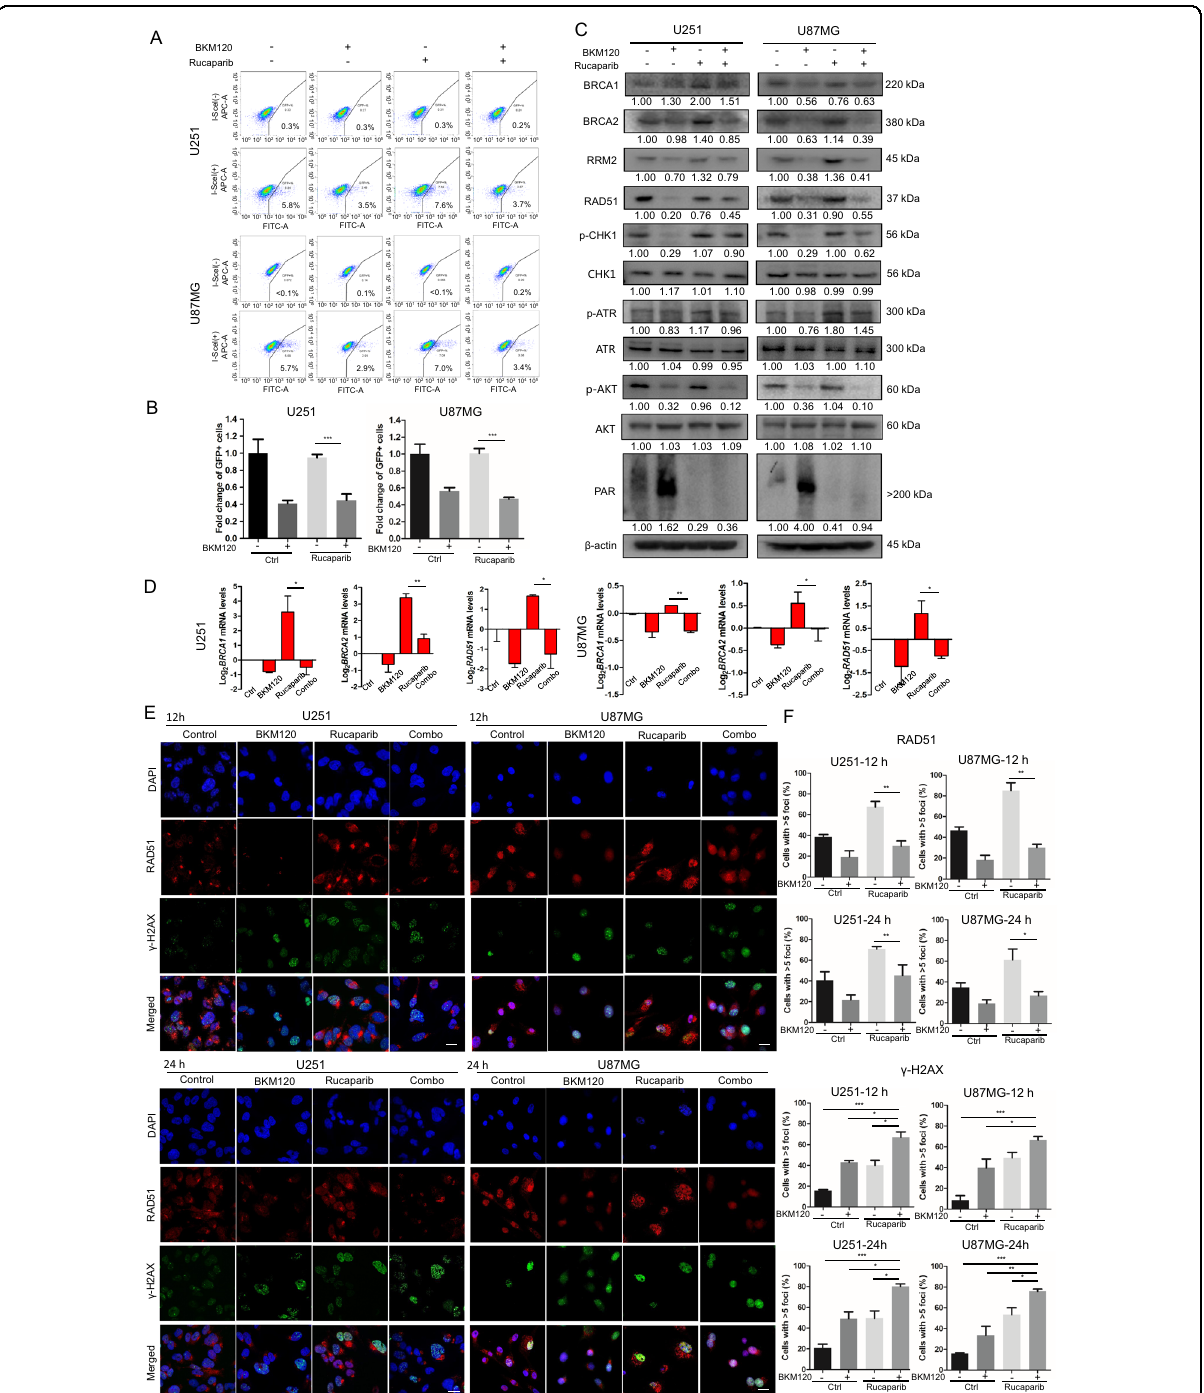
Fig. 3 Effects of BKM120 and rucaparib as single agents or in combination on HR repair. A U251 and U87MG cells were transfected with DR- GFP plasmid and pCBASceI plasmid using Lipofectamine 3000. Cells were treated with BKM120 or/and rucaparib for 72 h and then collected and resuspended in ice-cold PBS. GFP intensity was analyzed by fl ow cytometry. B The percentage of GFP-positive cells represents HR repair ef fi ciency. C , D U251 and U87MG cells were treated with BKM120 and/or rucaparib for 48 h. C Cells were collected for western blotting detection of DNA damage- and HR repair-related proteins, including BRCA1, BRCA2, RAD51, RRM2, p-ATR, p-CHK1, p-AKT, ATR, CHK1, and PAR. D Quantitative reverse transcription PCR analysis of BRCA1, BRCA2, and RAD51 expression in two cancer cell lines. Gene expression was normalized to 18 s rRNA. E , F Cells were treated with BKM120 or/and Rucaparib for 12/24 h. Representative images of immuno fl uorescence staining of RAD51 and γ -H2AX in GBM cells Cell nuclei were stained with DAPI. Scale bar: 20 μ m. The percentage of cells with RAD51/ γ -H2AX foci was shown in ( F ). All data are presented as mean ± SD ( n = 3). * P < 0.05; ** P < 0.01; *** P < 0.001. Of fi cial journal of the Cell Death Differentiation